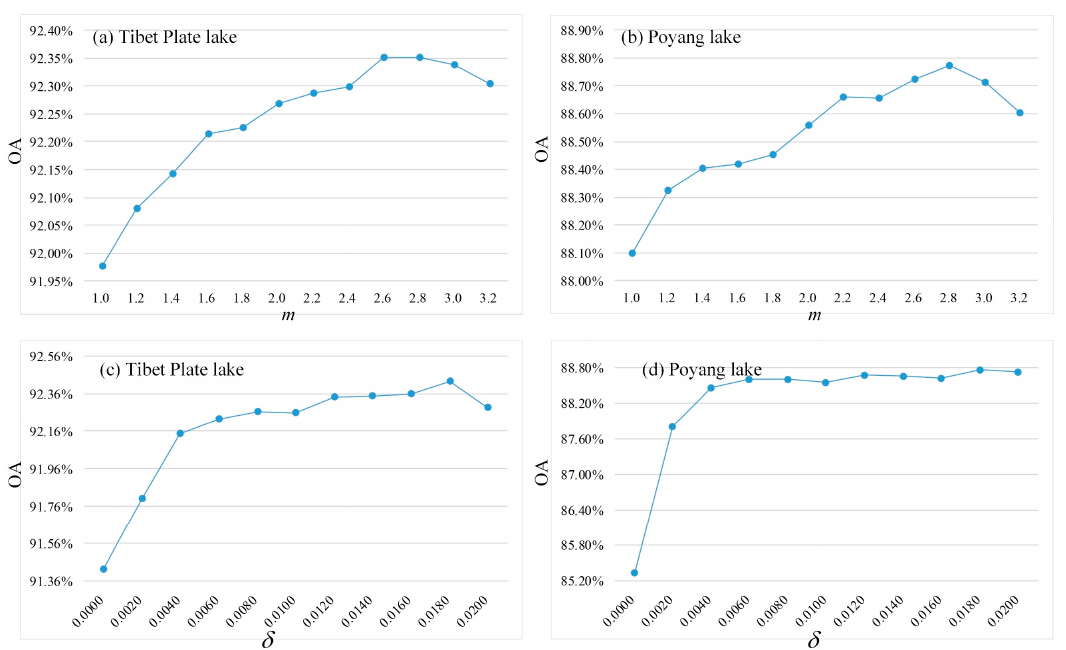
Figure 8. OA curves of the resultant water body maps produced by USWBM with different values of m and δ for Tibet Plate lake and Poyang lake. ( a ) OA curves of the results in Tibet plate lake with different values of m, ( b ) OA curves of the results in Poyang lake with different values of m , ( c ) OA curves of the results in Tibet plate lake with different values of δ , ( d ) OA curves of the results in Tibet plate lake with different values of δ